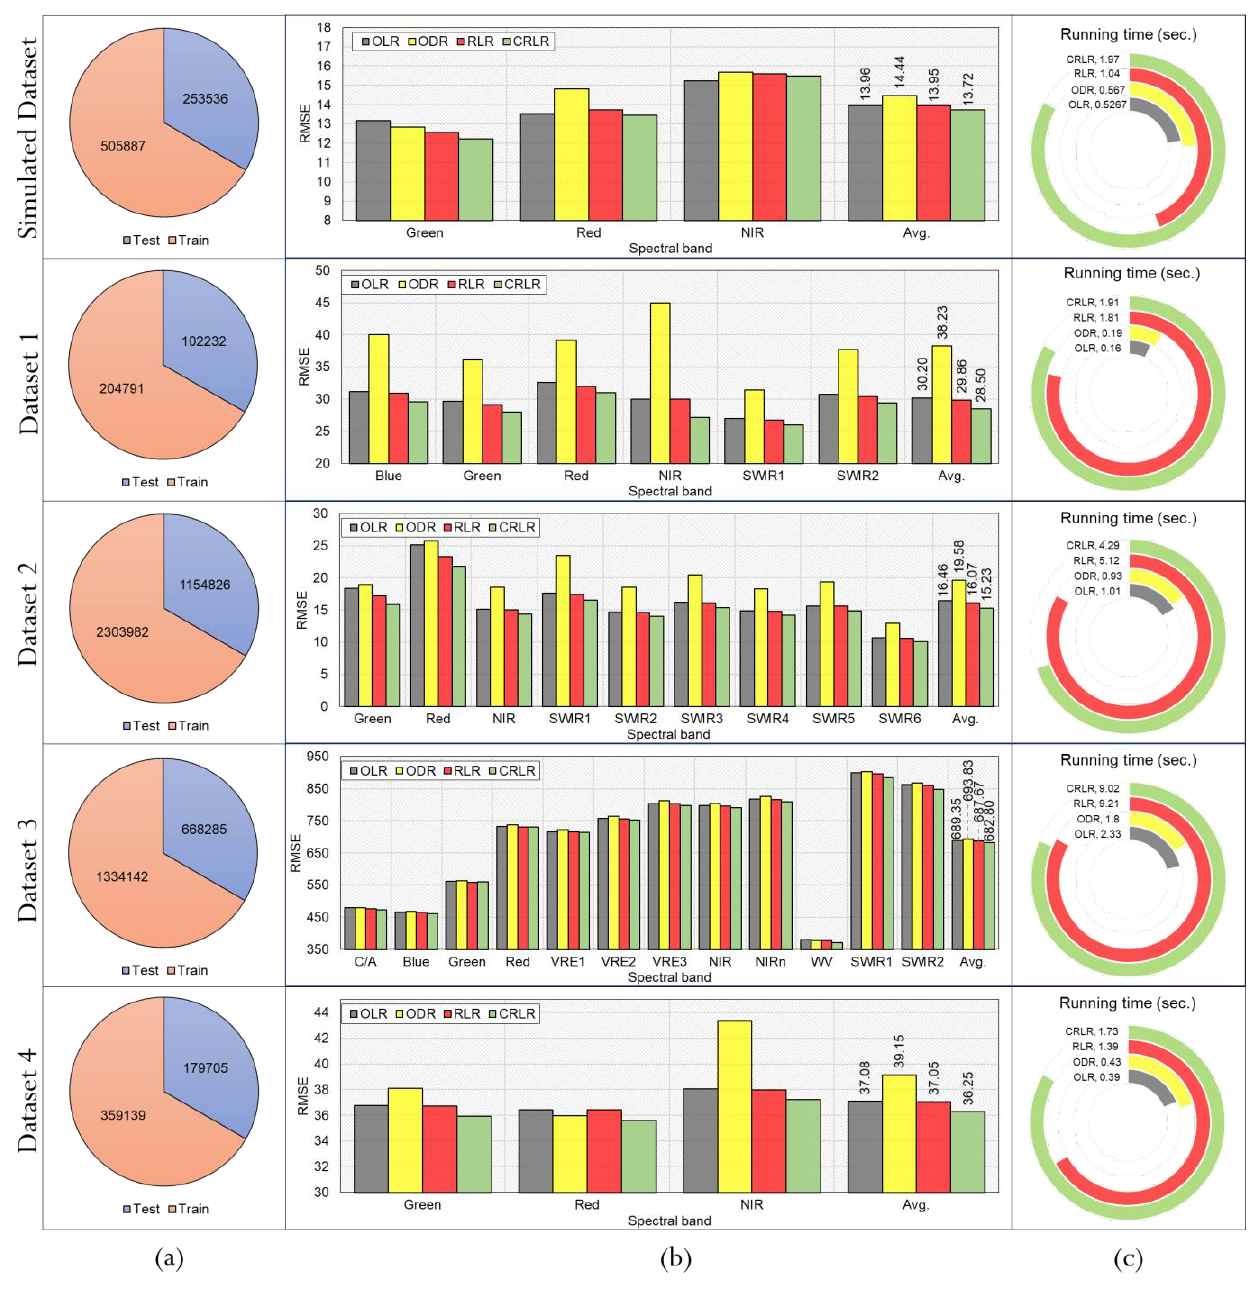
Figure 6. The comparative results of the OLR, ODR, RLR, and CRLR models in the proposed RRN process. ( a ) Number of training and test samples, ( b ) the RRN performance resulted from considered models, and ( c ) their processing time for the simulated dataset and datasets 1 – 4.